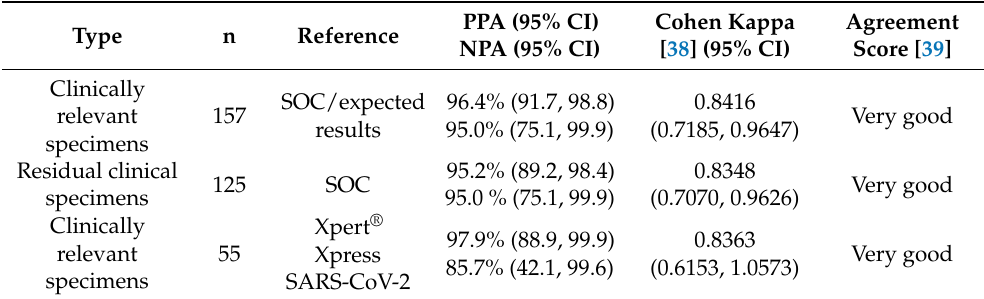
Table 1. Accuracy of the Xpert ® Xpress CoV-2 plus test compared to qualitative reference results. Positive percentage agreement (PPA), negative percentage agreement (NPA) and agreement are shown, including 95% CI. Clinically relevant specimens refer to both residual clinical specimens and reference materials. SOC: standard of